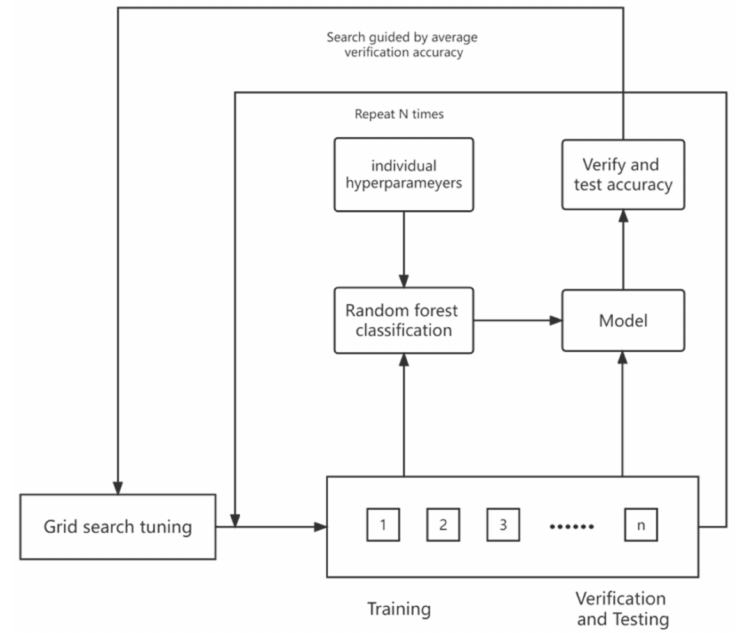
Figure 4. Hyper-parameter tuning